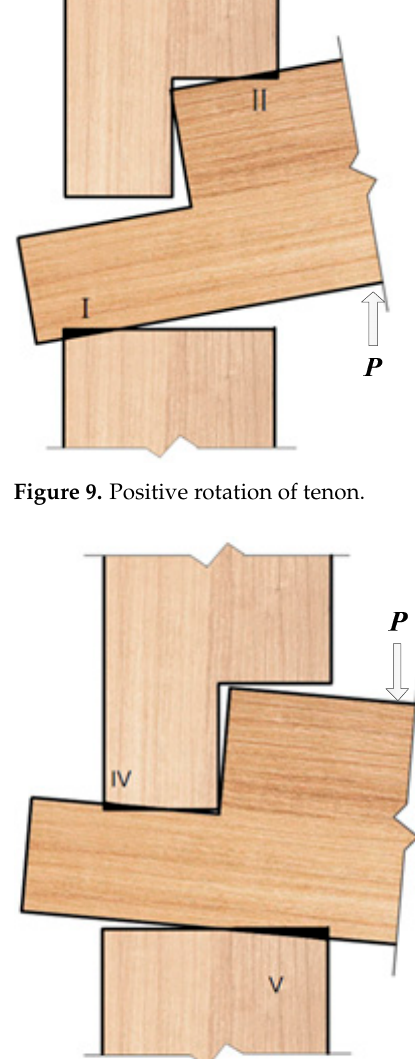
Figure 10. Negative rotation of